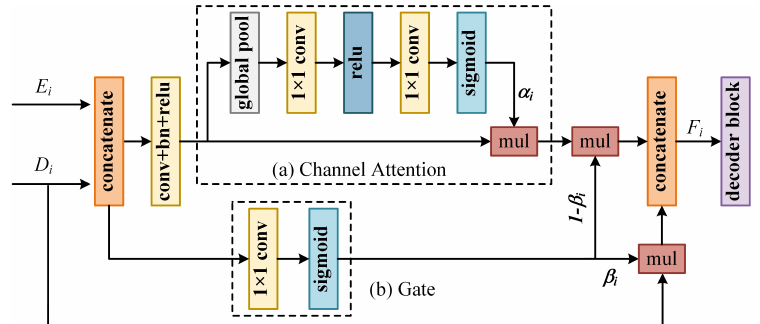
Figure 3. Structure of the proposed gated-attention refined fusion